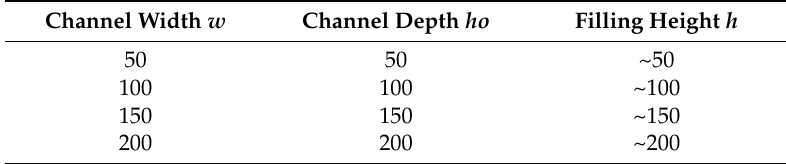
Figure 7. Profile measurements of micro-array channels with different widths: ( a ) 50 μ m; ( b ) 100 μ m; ( c ) 150 μ m; ( d ) 200 μ m. Table 1. Filling quality measurement of micro-array channels after micro-embossing using UFG LZ91 Mg-Li alloy ( μ m).